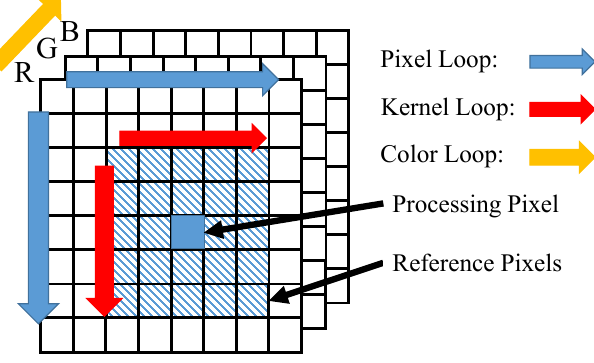
Figure 3. Loops in 2D finite impulse response